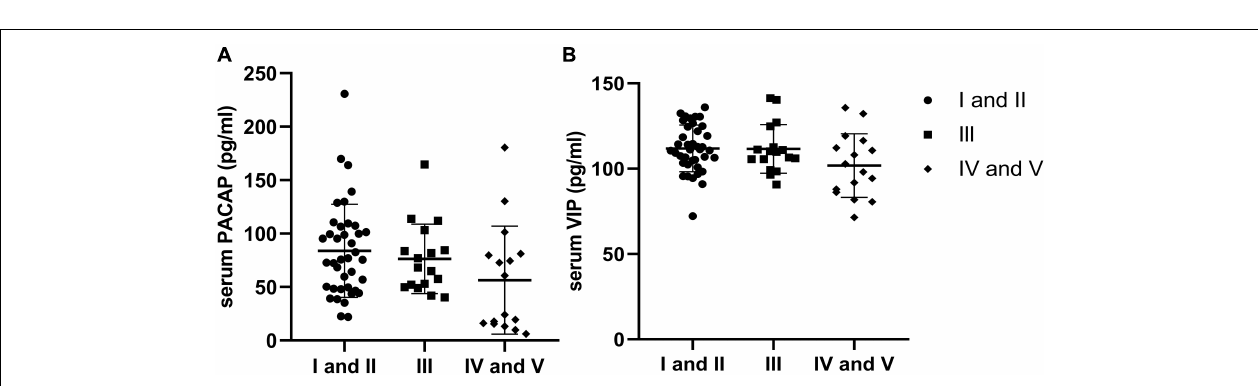
FIGURE 2 | Correlation between serum pituitary adenylate-cyclase activating polypeptide (PACAP) and vasoactive intestinal peptide (VIP) levels. (A) A positive correlation between serum levels of PACAP and VIP in the total groups (Pearson’s correlation coefficient r = 0.478, P < 0.001, and n = 143). (B) A positive correlation between serum levels of PACAP and VIP in the PD group (Pearson’s correlation coefficient r = 0.261, P < 0.05, and n = 72). (C) A positive correlation between serum levels of PACAP and VIP in the healthy control group (Pearson’s correlation coefficient r = 0.288, P < 0.05, and n = 71).